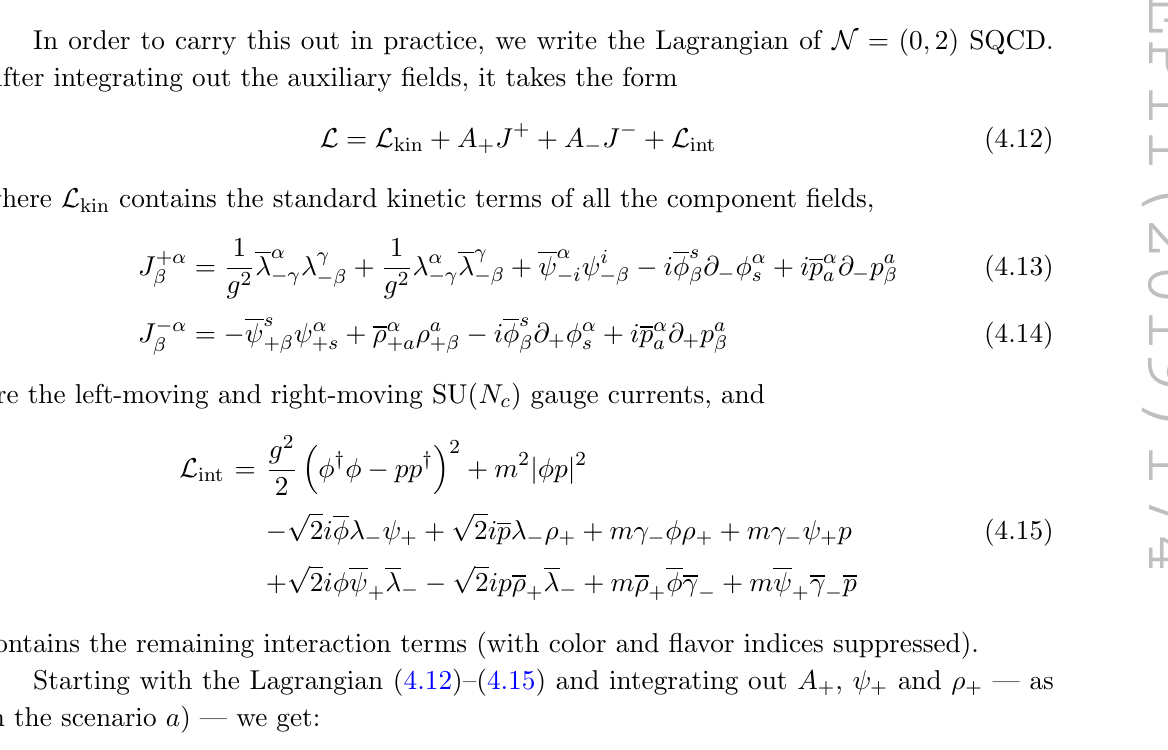
Figure 12 . Propagating (cid:12)elds in the light-cone approach ( a ) with x + as \time" and ( b ) with x (cid:0) as